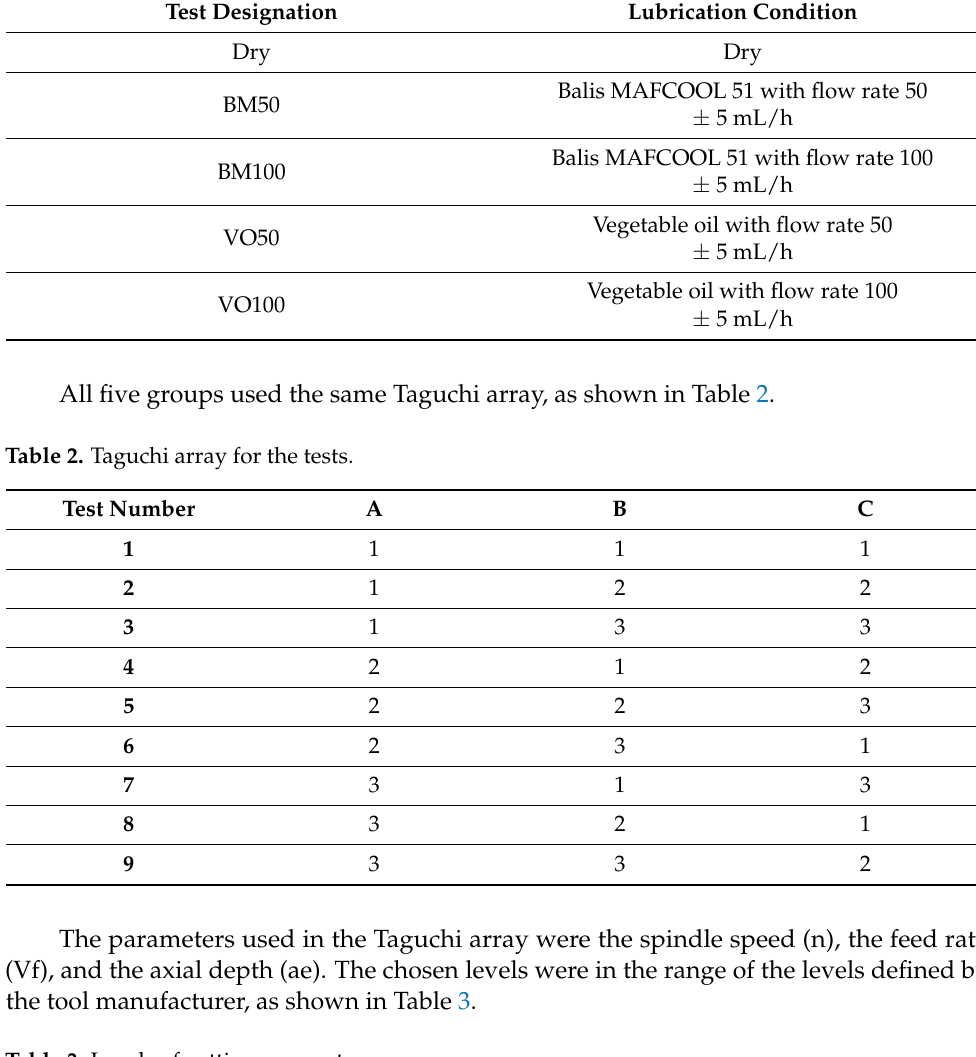
Table 3. Levels of cutting